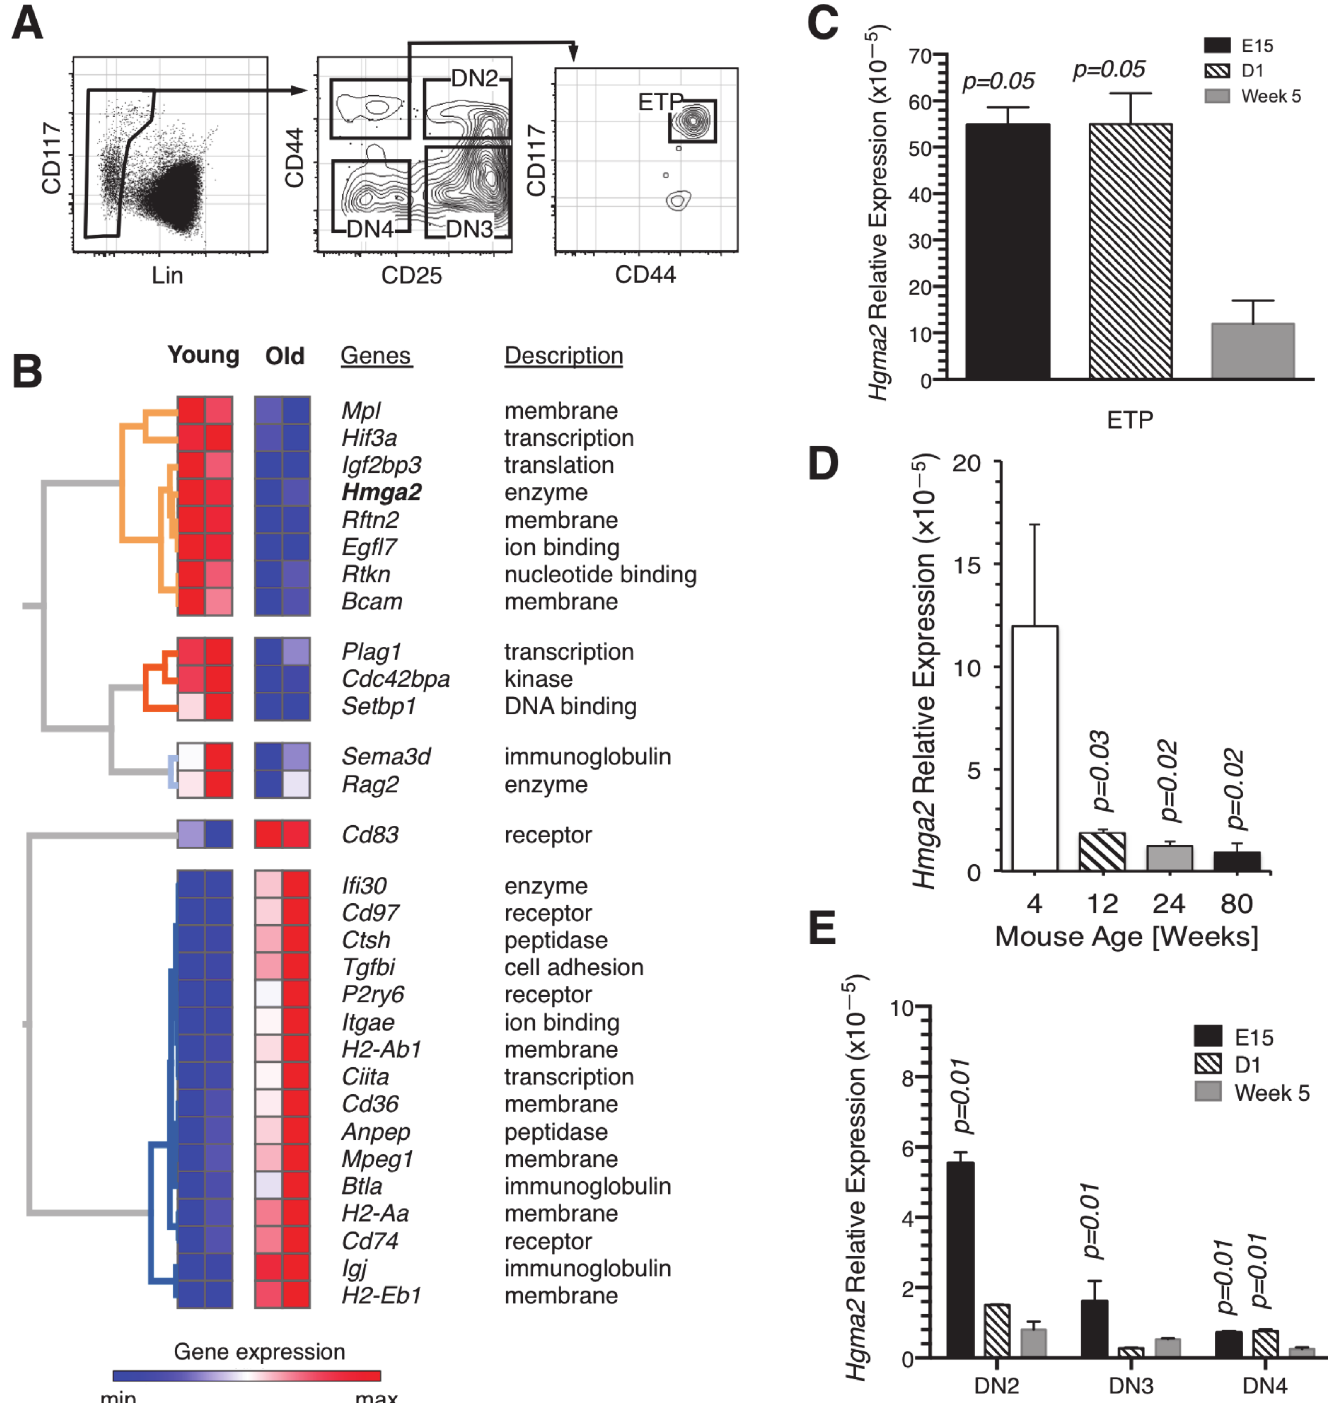
Fig 1. Whole transcriptome analysis of ETP. (A) Resolution of ETP and double negative thymocyte subsets. Live cells were gated based on lineage negativity (Lin - ) and CD44 and CD25 levels of expression as shown. ETP were further resolved as Lin - CD44 + CD25 - CD117 + cells. The thymus of 6 week old B6 mice was used to obtain the data shown in the FACS plots. (B) Hierarchical clustering of selected genes. Variance stabilized RNA-seq expression estimates are shown for each gene and replicated condition. The color scale shows the relative value. Gene descriptions are from Gene Ontology molecular function annotations. (C) Expression of Hmga2 relative to Gapdh in ETP from E15 embryos (E15), day 1 neonates (D1), and 5 week old (Week 5) B6 mice measured by qPCR. (D) Expression of Hmga2 relative to Gapdh in ETP harvested from 4 week, 12 week, 24 week, and 80 week old B6 mice measured by qPCR. (E) Expression of Hmga2 relative to Gapdh in DN2, DN3 and DN4 progenitors isolated from E15 embryos (E15), day 1 neonates (D1), and 5 week old (Week 5) B6 mice measured by qPCR. The data in panels (C) and (E) are from the same group of mice.